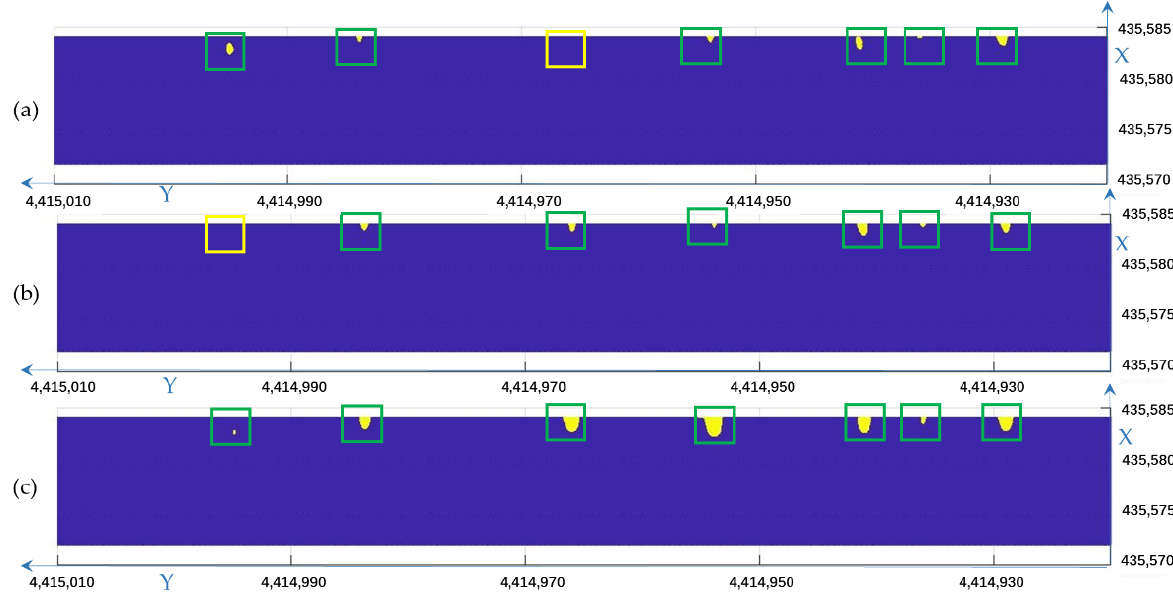
Figure 20. Results of subsidence detection (m): ( a ) 0 – 5 mm; ( b ) 0 – 10 mm; ( c ) 0 – 15 mm.